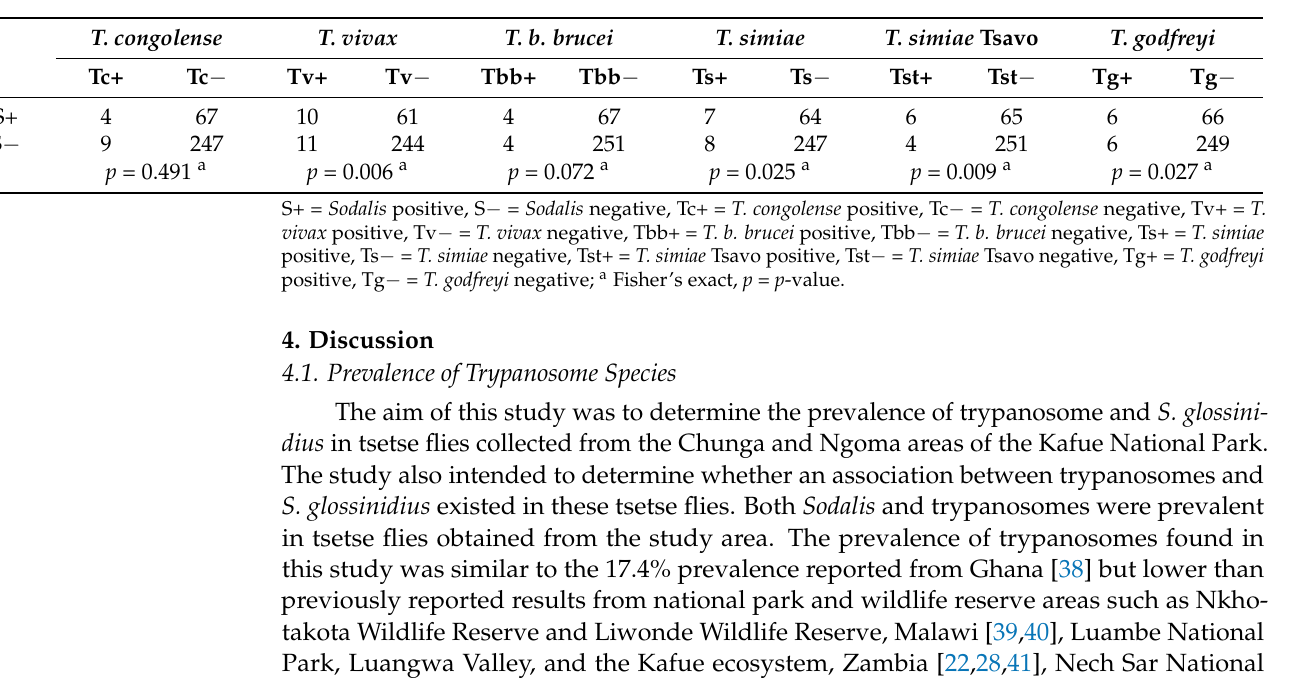
Table 7. Association between S. glossinidius and Trypanosoma species detected in tsetse